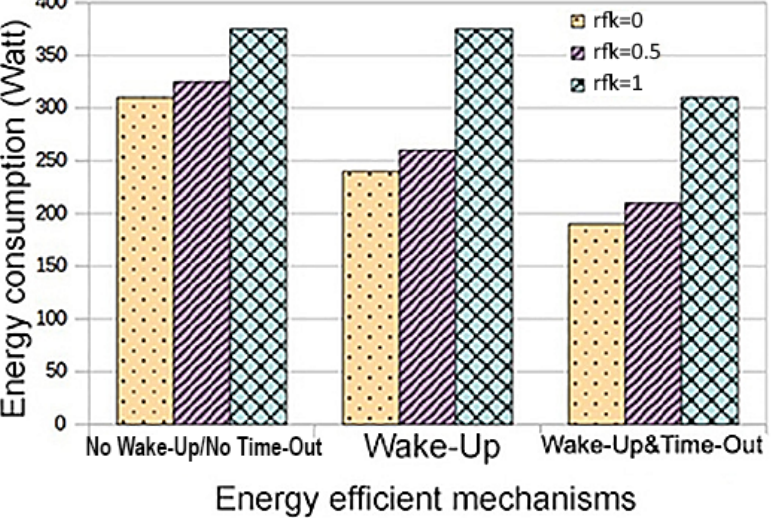
Figure 7. Energy consumption for different attacker intervention rates r fk when λ down = 0.6 and λ up =